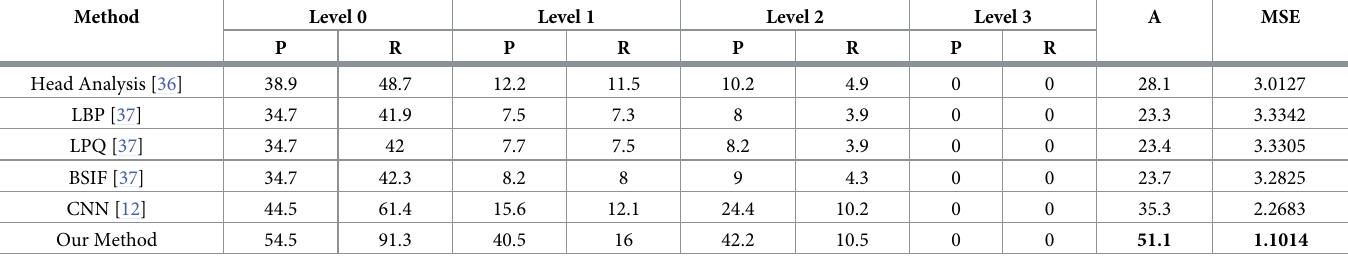
Table 6. Comparison our proposed method with the state-of-the-art methods. P denotes to precision, R denotes recall, A denotes classification accuracy, and Att is short for attention. Method